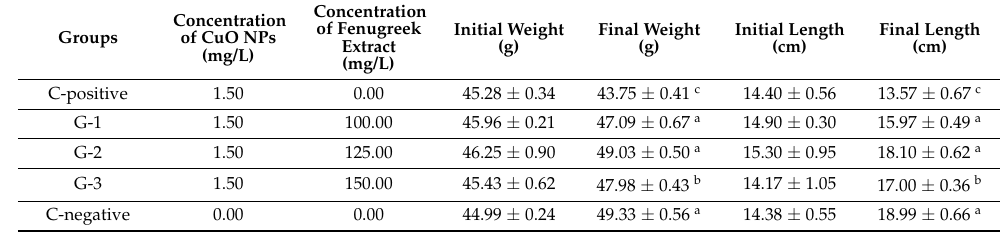
Table 1. Effects of CuO NPs and different concentrations of the fenugreek ( T. foenum-graecum ) extract on the body weight and length of the common carp ( C . carpio ) experimentally exposed for 28 days. Data are expressed as means ± standard error (SE; n =